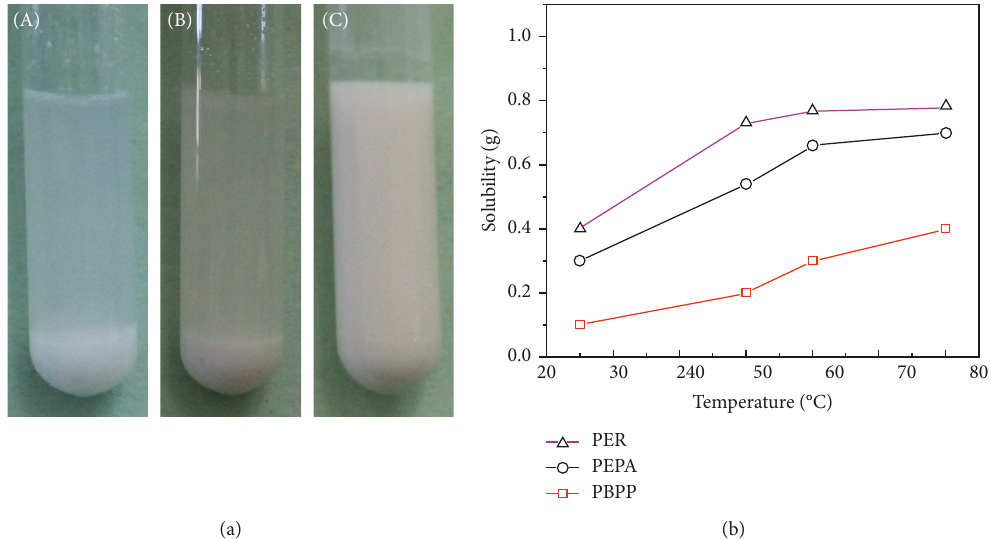
Figure 4: Digital photos and graphs of PER (A), PEPA (B), and PBPP (C) (1g) dispersed in H